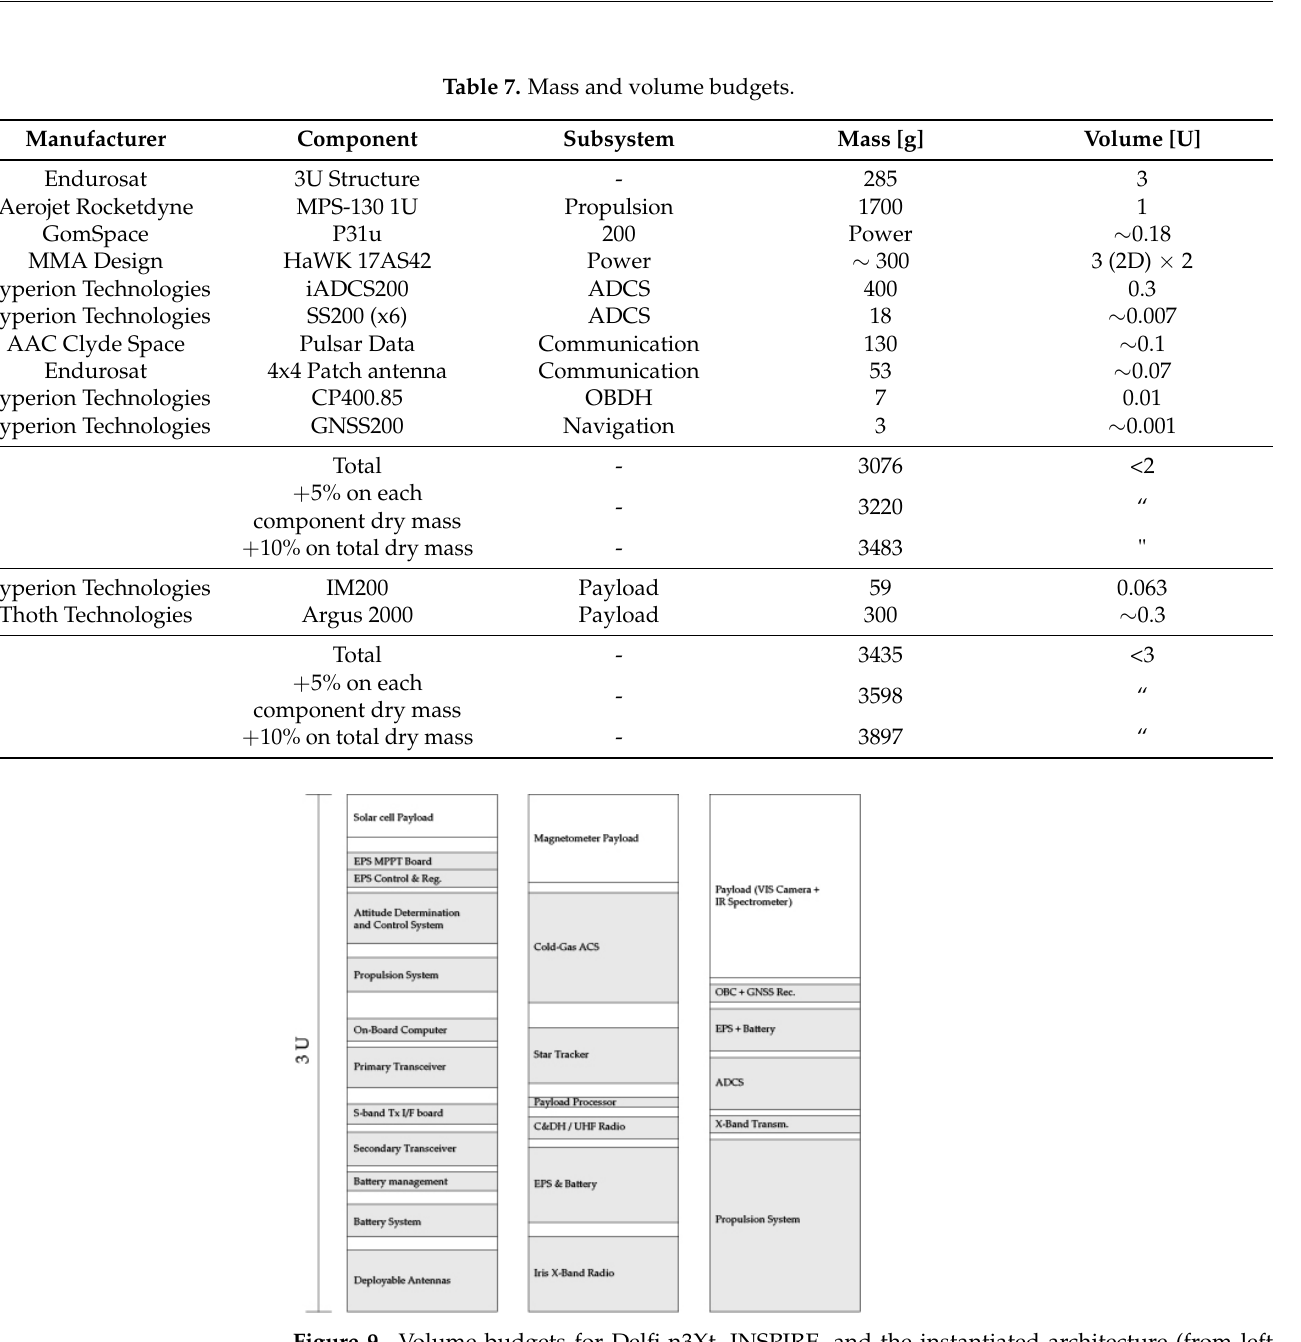
Figure 9. Volume budgets for Delfi-n3Xt, INSPIRE, and the instantiated architecture (from left to